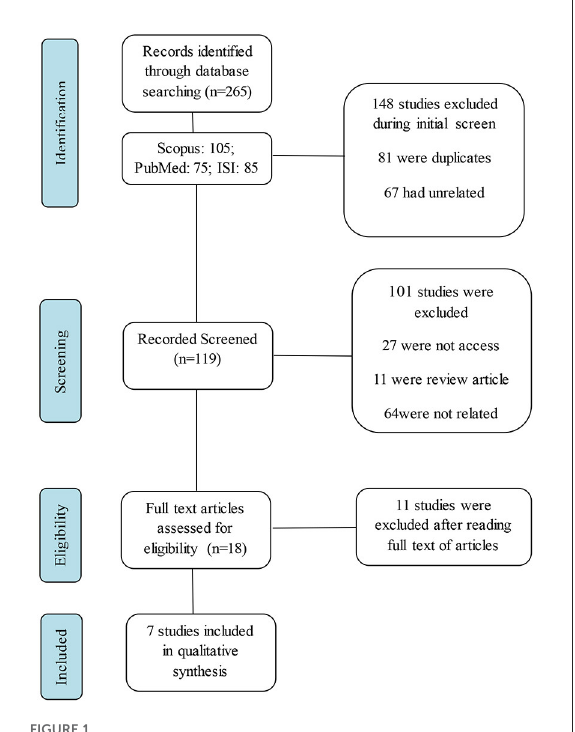
FIGURE1 Flowchart of the literature search and strategy for the selection of relevant